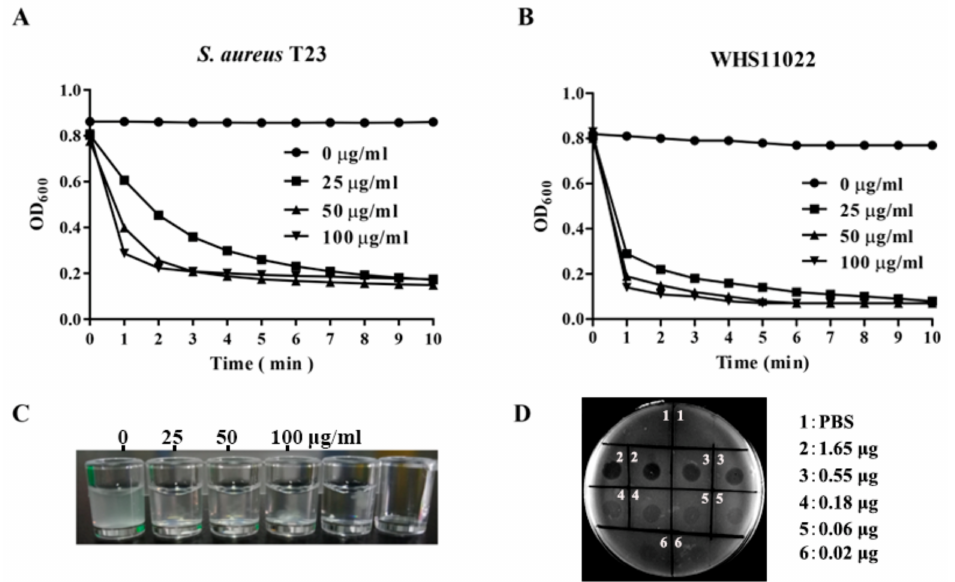
Figure 2. Bactericidal activity of ClyC. Lytic activity of ClyC against MRSA T23 ( A ) and S. aureus WHS11022 ( B ) at different concentrations (0, 25, 50, and 100 µ g/mL). ( C ) Representative pictures of S. aureus T23 suspensions after treatment with different concentrations (0, 25, 50, and 100 µ g/mL) of ClyC for 10 min. ( D ) Plaques assay result showing ClyC (0.02–1.65 µ g/area) activity against S. aureus